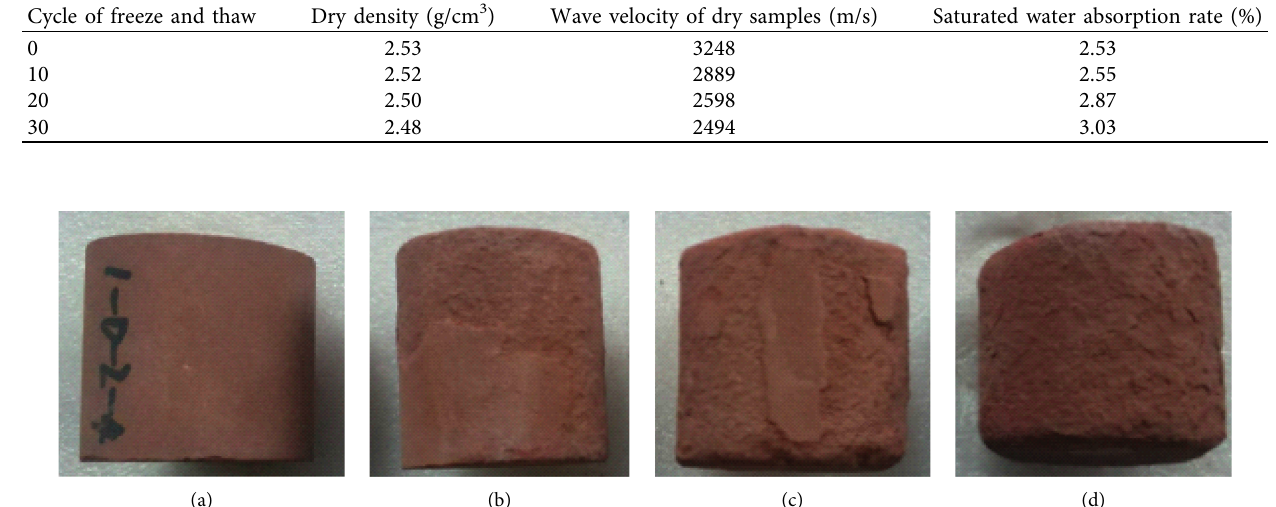
Figure 2: Freeze-thaw damage pattern of rock sample. (a) 0 cycle, (b) 10 cycles, (c) 20 cycles, and (d) 30 cycles.